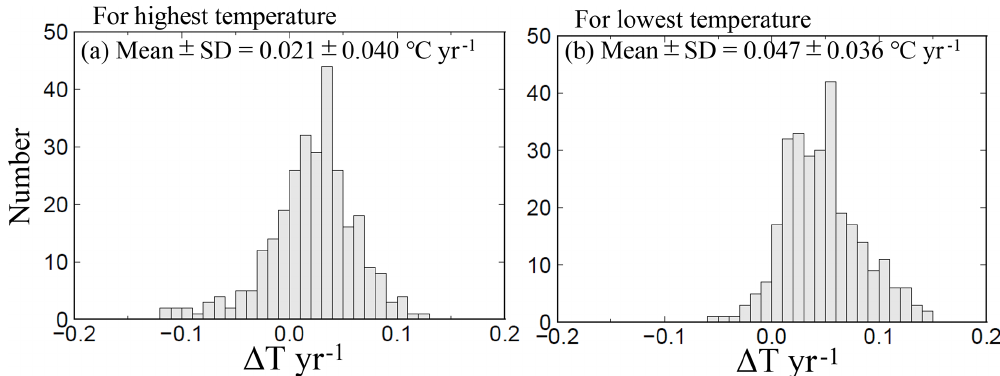
Figure 13. Same as Fig. 7 but showing the highest and lowest temperature trends at 289 sites (selected by quality control step